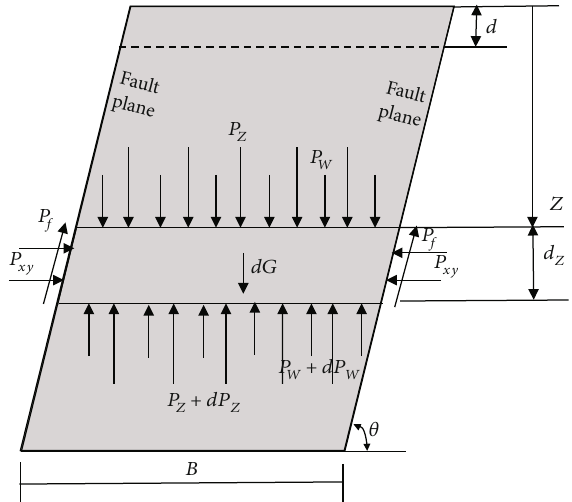
Figure 1: The microelement mechanic model of water-rich fault fracture